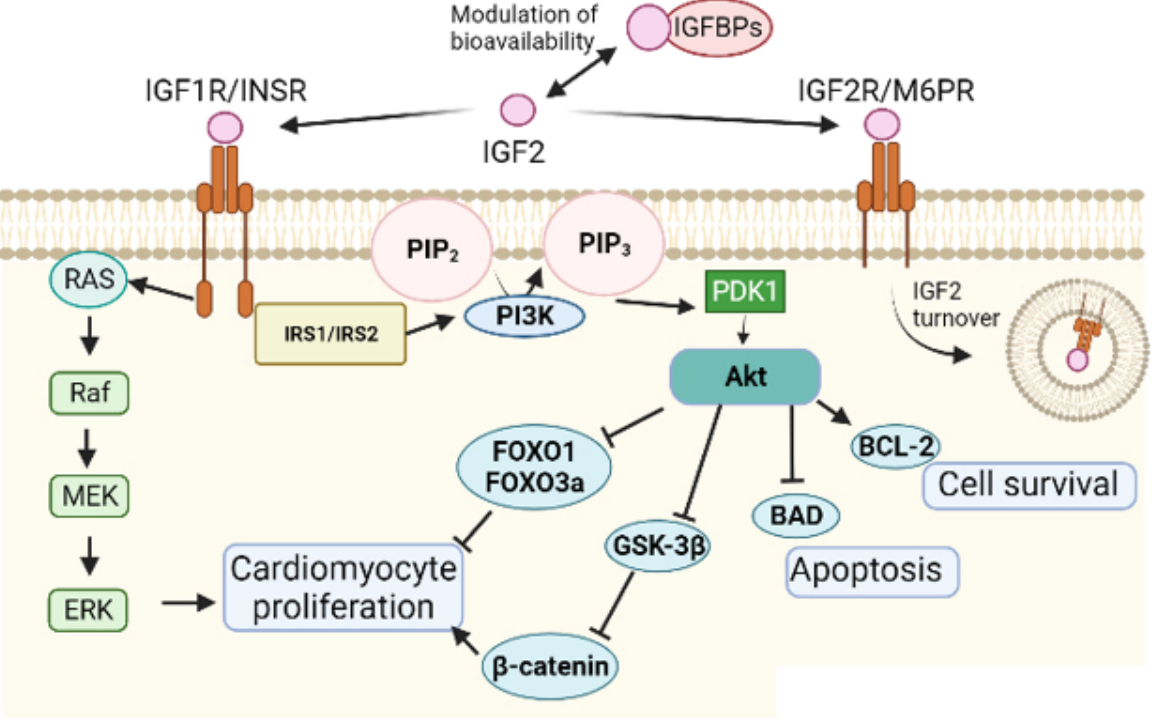
Figure 2. The insulin growth factor signalling pathway in myocardial development. The relative importance of IGFR1 and INSR in the transduction of the mitogenic IGF2 signal has been debated, but IGF1R seems to be the main receptor in the embryonic cardiomyocytes. IGFBPs modulate bioavailability of IGF2. IGF2R is a negative regulator of the system by receptor-mediated endocytosis of IGF2. The main transduction pathways activated by IGF1R are the ERK/MAPK and the PI3K/Akt cascades, leading to proliferation and survival of the